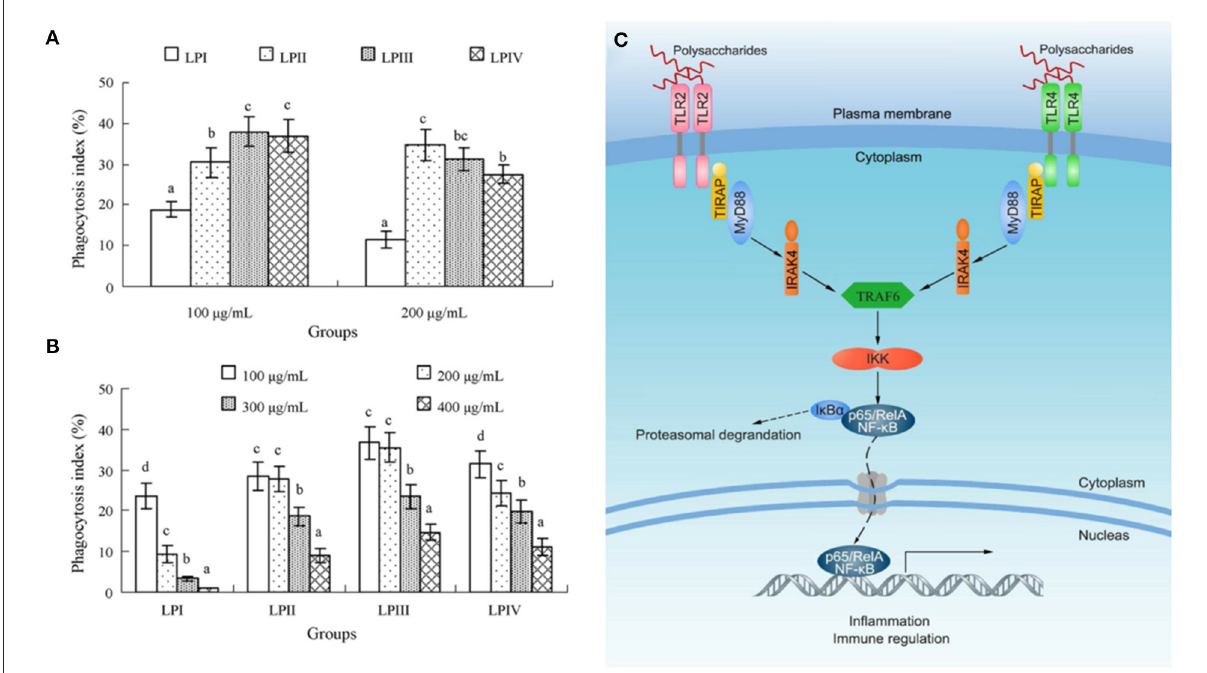
FIGURE4 The activation of macrophages and the enhancement of phagocytic function are indicators of the enhancement of LPs immunomodulation, anti-tumor and anti-inflammatory activities. (A) The comparison of phagocytosis indexes of LPI–IV at 100 or 200 µ g/mL. (B) The phagocytosis indexes of LPI-IV in the dose range of 100–400 µ g/mL (34). (C) Possible molecular mechanism of LPs activating macrophages